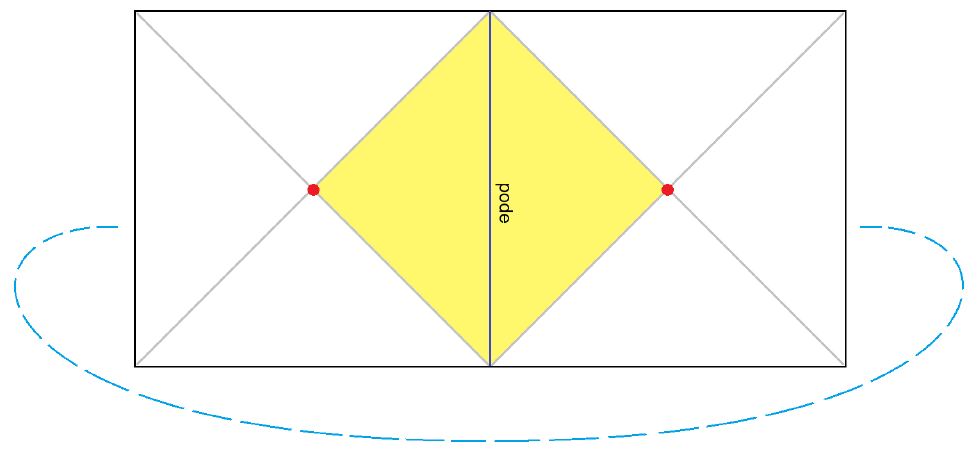
Figure 2. Conformal diagram for 2D de Sitter space and the static patch defined by a past and future pair of asymptotic points. The static patch (yellow) is the intersection of the causal future of the past point and the causal past of the future point. The intersection of the two light cones, shown as red dots, defines the bifurcate horizon. The dashed blue curve indicates identification of the left and right